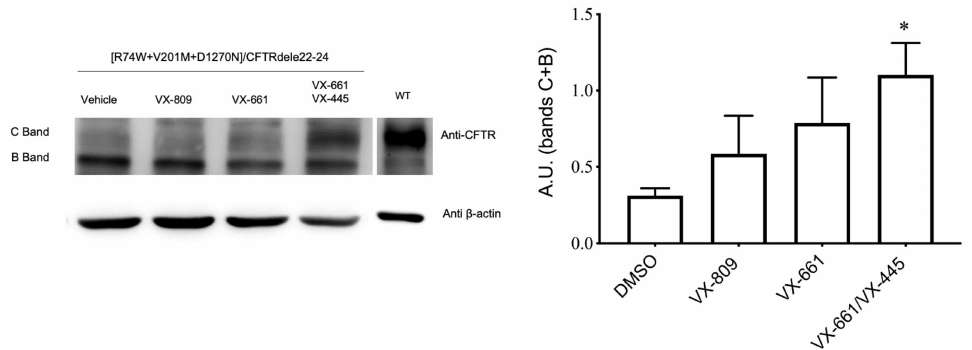
Figure 5. Expression of CFTR protein in [R74W;V201M;D1270N]/CFTRdele22_24 in rectal organoids. ( left ) Total protein extracts were separated on a 7.5% PAGE gel and CFTR was detected using anti- CFTR mixed mouse monoclonal antibodies (450, 570 and 596). In the CF variant, the treatment for 24 h with CFTR modulator VX-809 (3 µ M) improves the expression of band C (lane 2). The combination of VX-661 (3 µ M) and VX-445 (3 µ M) further improves CFTR expression (lanes 3–4) as compared to untreated lysate (lane 1). A β -Actin polyclonal antibody was used as loading control; ( right ) Densitometric analysis of the results shown as representative Western blots in A. The results of the densitometric analysis shown summarized the β -actin-normalized data (C + B bands) from a minimum of three independent experiments. * p < 0.05 (Mann–Whitney